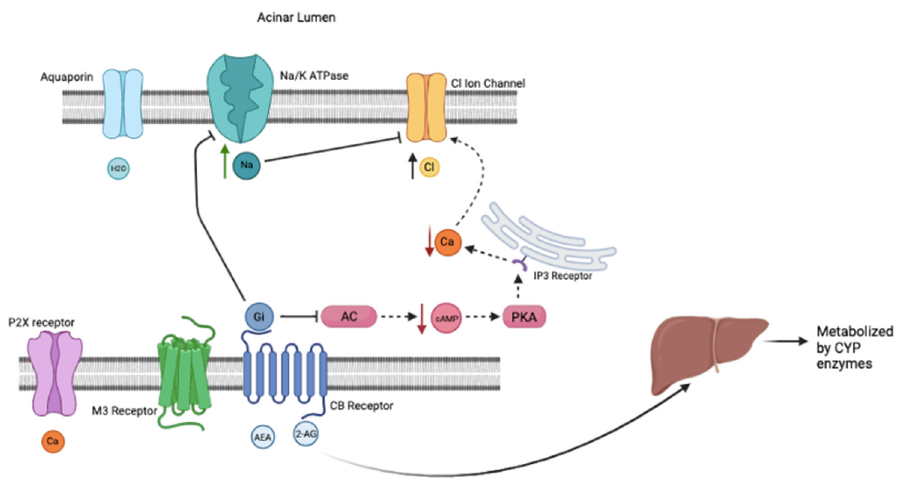
Figure 2. Active Cannabinoid Use Pathway. AEA and 2-AG act on the CB Receptors, thus activating the Gi subunit. This causes downstream inhibitory effects on cAMP, intracellular calcium, the Na/K ATPase pump, and the aquaporin channel. The increased intracellular sodium and decreased intracellular calcium inhibit the chloride ion channel, preventing the release of chloride to form salivation. Because the chloride channel is closed and there is no increased chloride gradient within the lumen, sodium and water do not move into the acinar lumen via their respective channels. Created with BioRender.com (accessed on 1 April 2022).